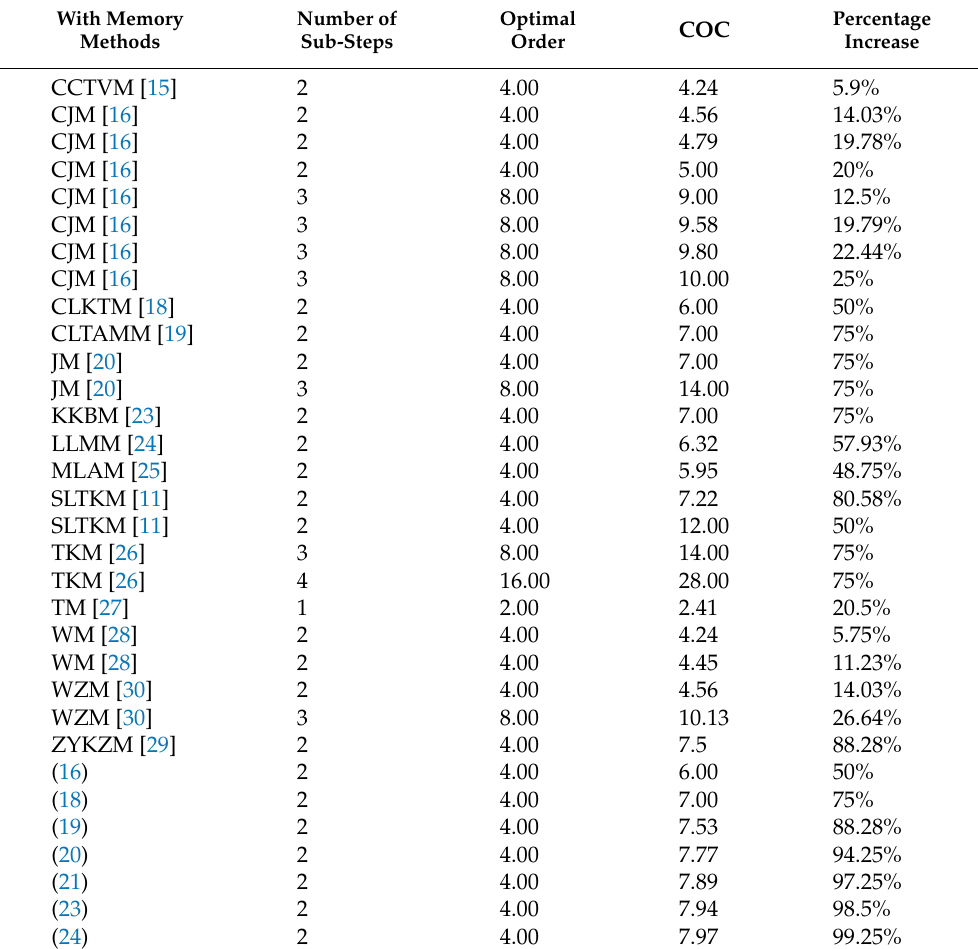
Table 8. Comparison improvement of convergence order of the proposed method with other schemes. With Memory